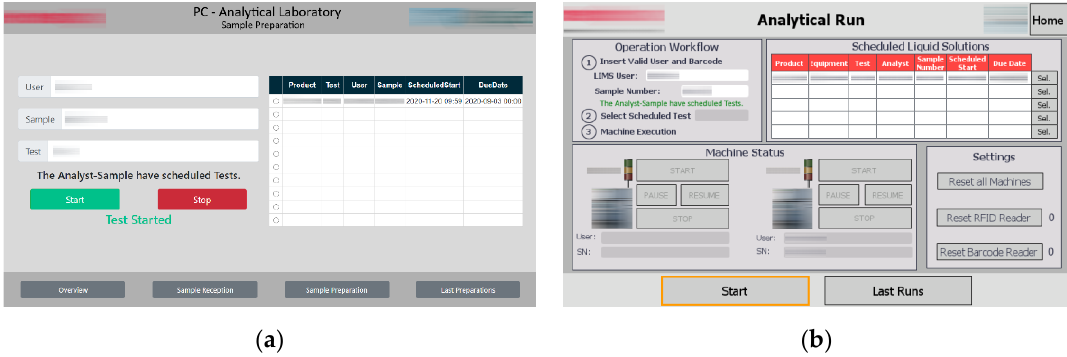
Figure 7. Dashboards tasks developed: ( a ) Sample preparation — PC Platform; ( b ) Analytical Run — PLC Platform.